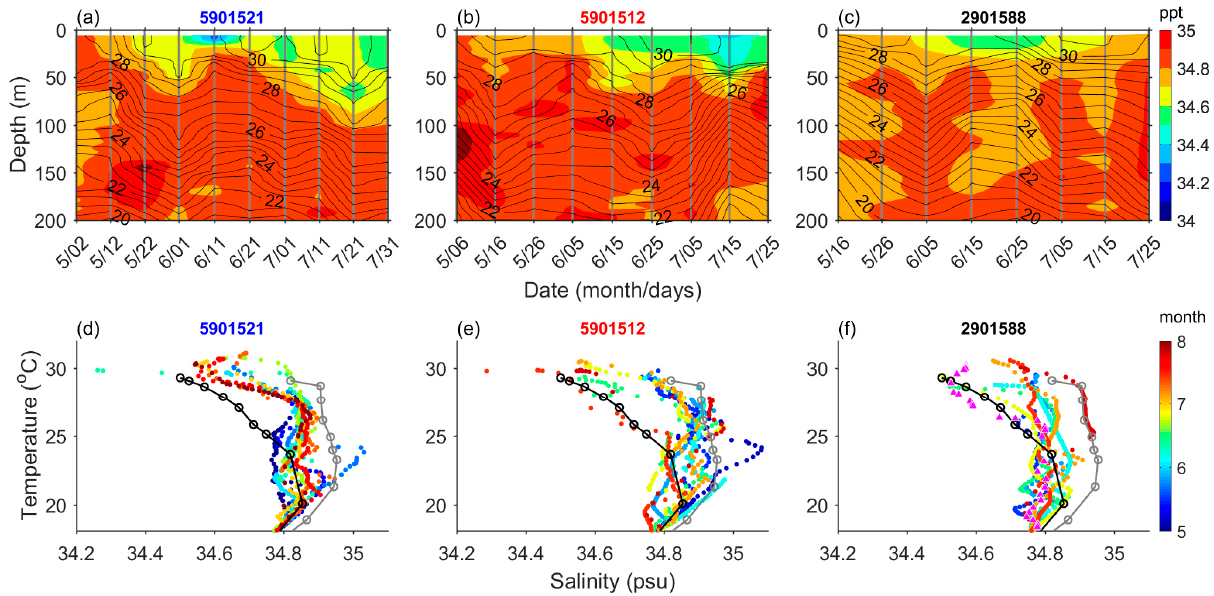
Figure 5. ( a – c ) Time series of salinity (color shaded) and temperature (contours) profiles correspond- ing to three selected Argo floats with the WMO numbers of 5901521, 5901512, and 2901588, from May to July 2010. The locations of these three Argo floats are marked in Figure 3. ( d – f ) Temperature– salinity (TS) diagrams corresponding to the profiles of three selected Argo floats shown in ( a – c ), respectively. Colors show the time in the calendar month. The magenta triangles in ( f) show the TS properties obtained from the CTD casts near 137 ◦ E and 23 ◦ N in July 2010. Black and gray curves with circles show the background TS properties averaged in June and July, located at the black and magenta star, respectively, shown in Figure 1a. Note: Not all data points are shown in the figures for better clarity, but the scientific results are not affected by the unshown data